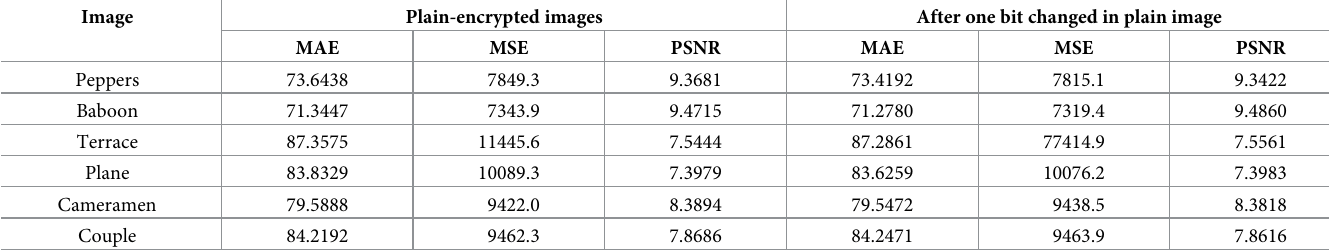
Table 8. Comparison of MAE, MSE and